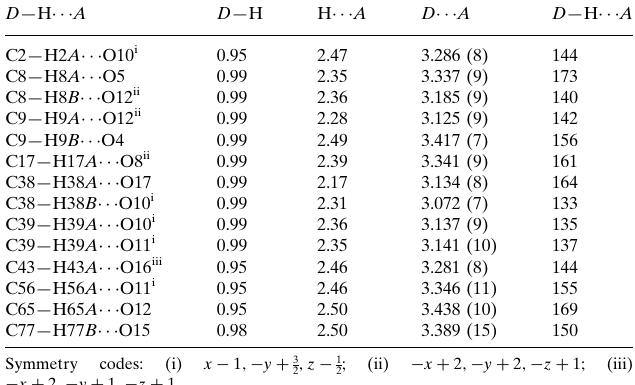
Hydrogen-bond geometry (A˚ , (cid:3)